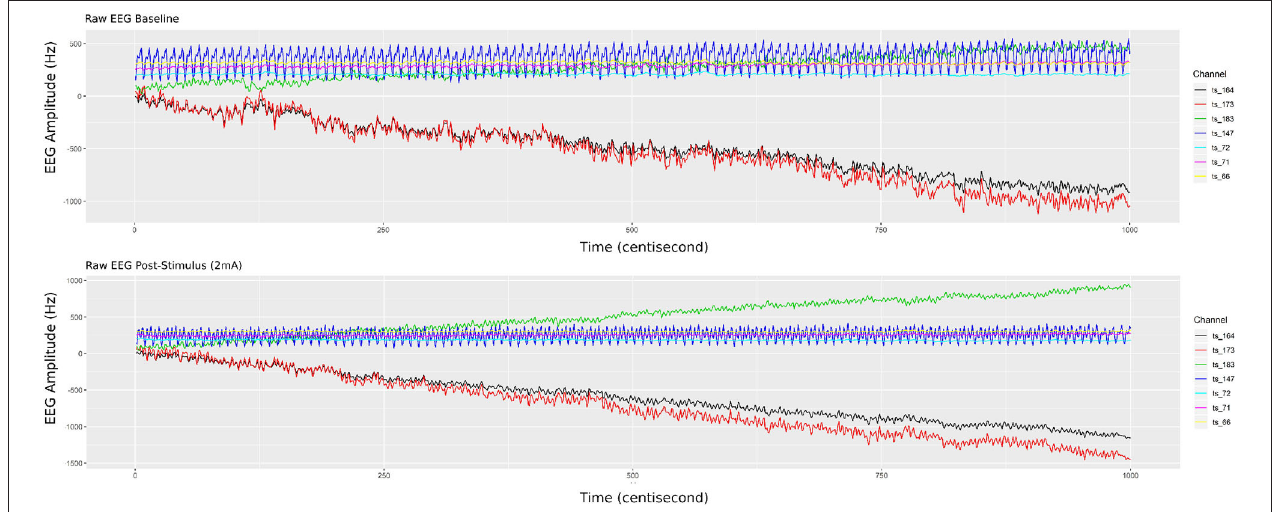
FIGURE 4 | Single participant EEG raw signals from 5 min of recorded biosignals (top panel) during the resting state and (bottom panel) after HD-tDCS–Anodal Center 2 mA–stimulation. The brain responses’ amplitude (on the y-axis), from the raw EEG signals, increased after the stimulation.